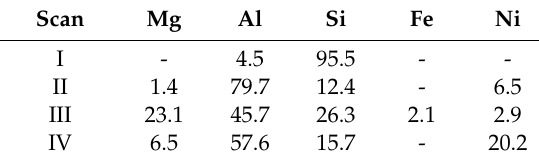
Table 15. Results of EDS scans corresponding with areas indicated by arrows in Figure 18 (in at %).